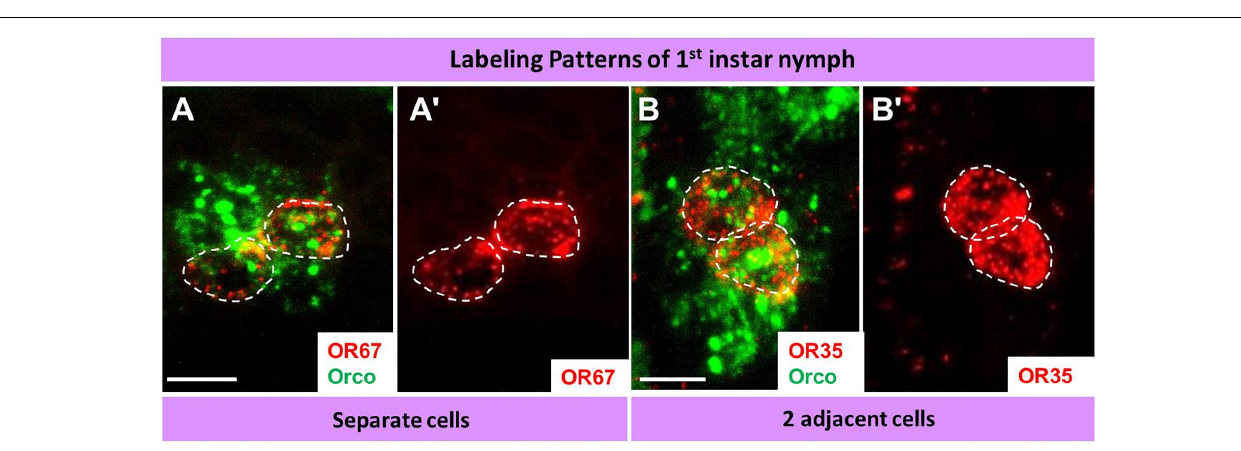
FIGURE 8 | During early development (1st instar nymph) a distinct OR type is only expressed in relatively few cells in basiconic sensilla. In A–B’ cells expressing distinct OR types and Orco were visualized by means of two-color FISH using specific antisense riboprobes. The analyses of 10 µ m optical stacks from sections of 1st instar nymph antennae revealed only two patterns OR expression: solitary cells or cell pairs. White dash circles outline distinct OR cells. Scale bars, 10 µ